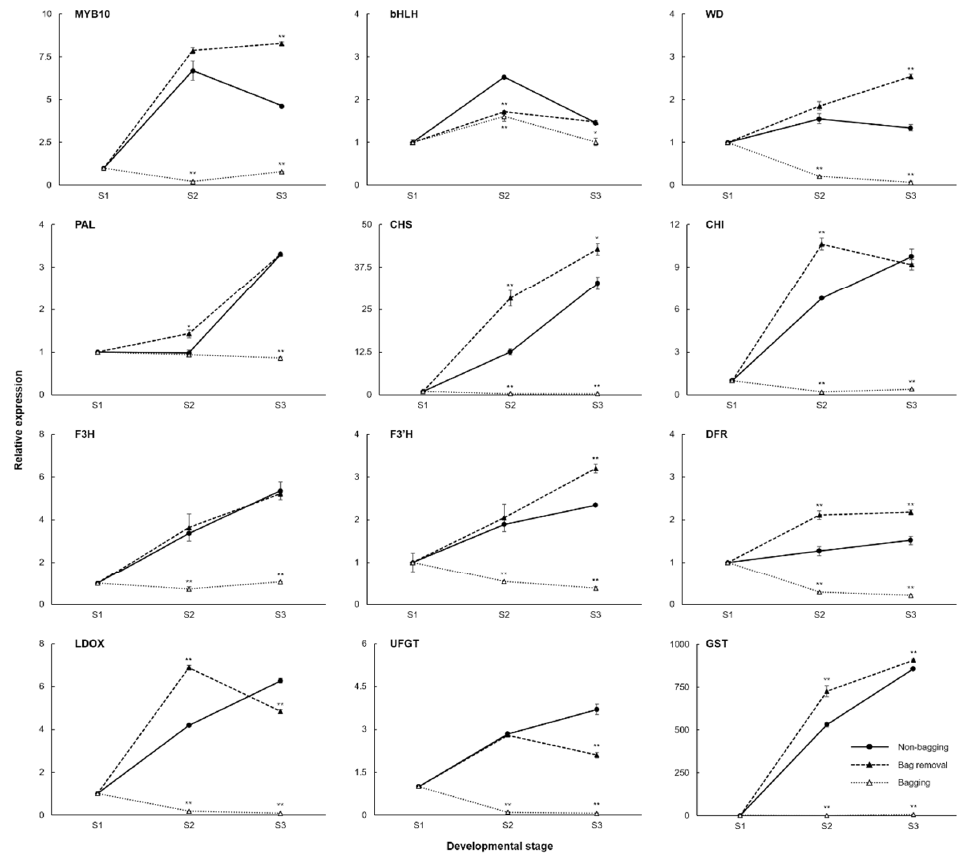
Figure 3. Quantitative real-time PCR analysis of anthocyanin-related genes in ‘Fuji’ apples cultivated under different bagging treatments: no bagging (control; labeled as “non-bagging”), bagging followed by bag removal (labeled as “bag removal”), and bagging with no bag removal (labeled as “bagging”). Apples were harvested at three time points: before paper-bagging (S1, DAFB 97) and then 1 and 4 weeks after bag removal (S2, DAFB 169 and S3, DAFB 191). The x -axis and y -axis indi-